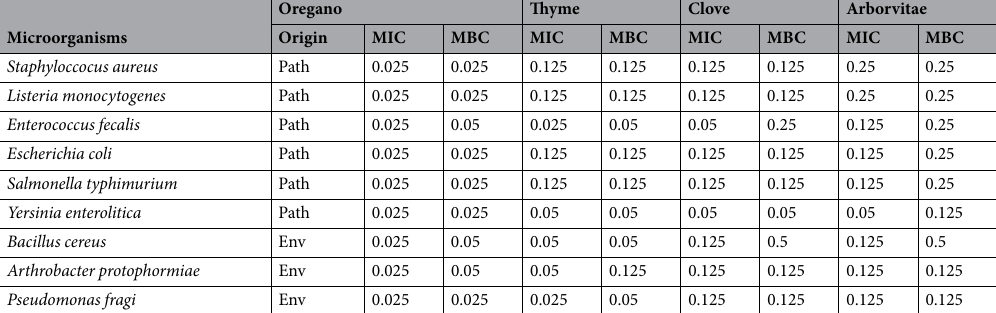
Table 1. Minimum inhibitory concentrations (MIC) and minimum bactericidal concentrations (MBC) (% w/v) of oregano, thyme, clove, and arborvitae EOs against tested bacteria. Each value is the mean of triplicate assays; Path – Pathogenic; Env – Environmental.